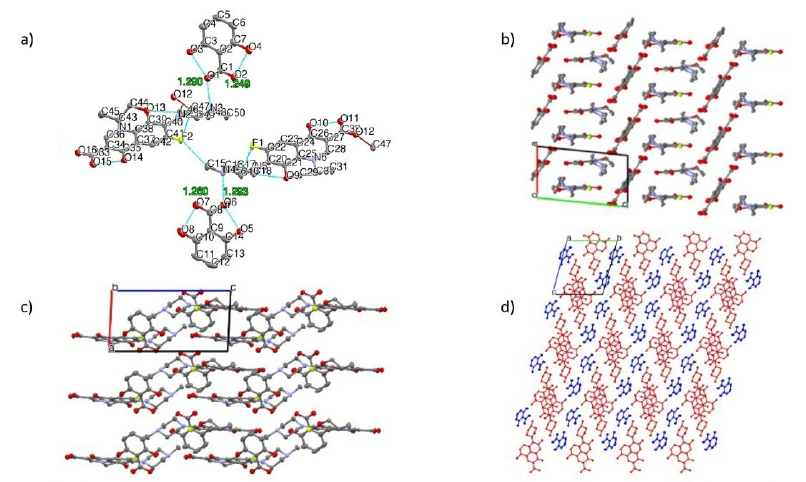
Figure 8. ( a ) Thermal ellipsoid drawing with atomic labeling scheme of LF-26 at 50% probability level. The dashed blue lines indicate intramolecular hydrogen bonds. ( b ) Packing motifs of LF-2,6 along the c -axis, hydrogen atoms are omitted for clarity. ( c ) Packing motifs of LF-26 along the b -axis and ( d ) c -axis with symmetry coloring. The red indicates LF molecules, while the blue color indicates 2,6-DHBA molecules.